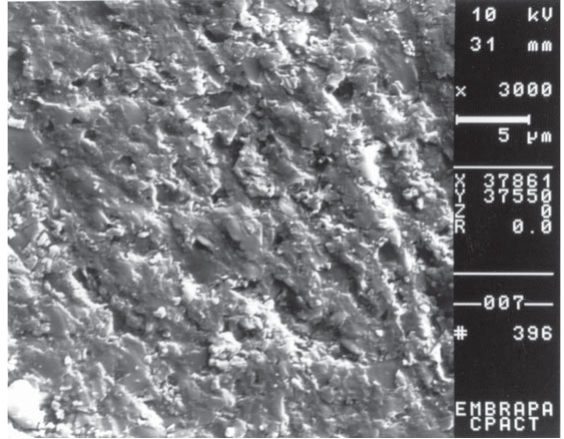
Figure 8. SEM micrography of Filtek Z250 surface after 90 days of aging (SEM original magnification 10000 ×